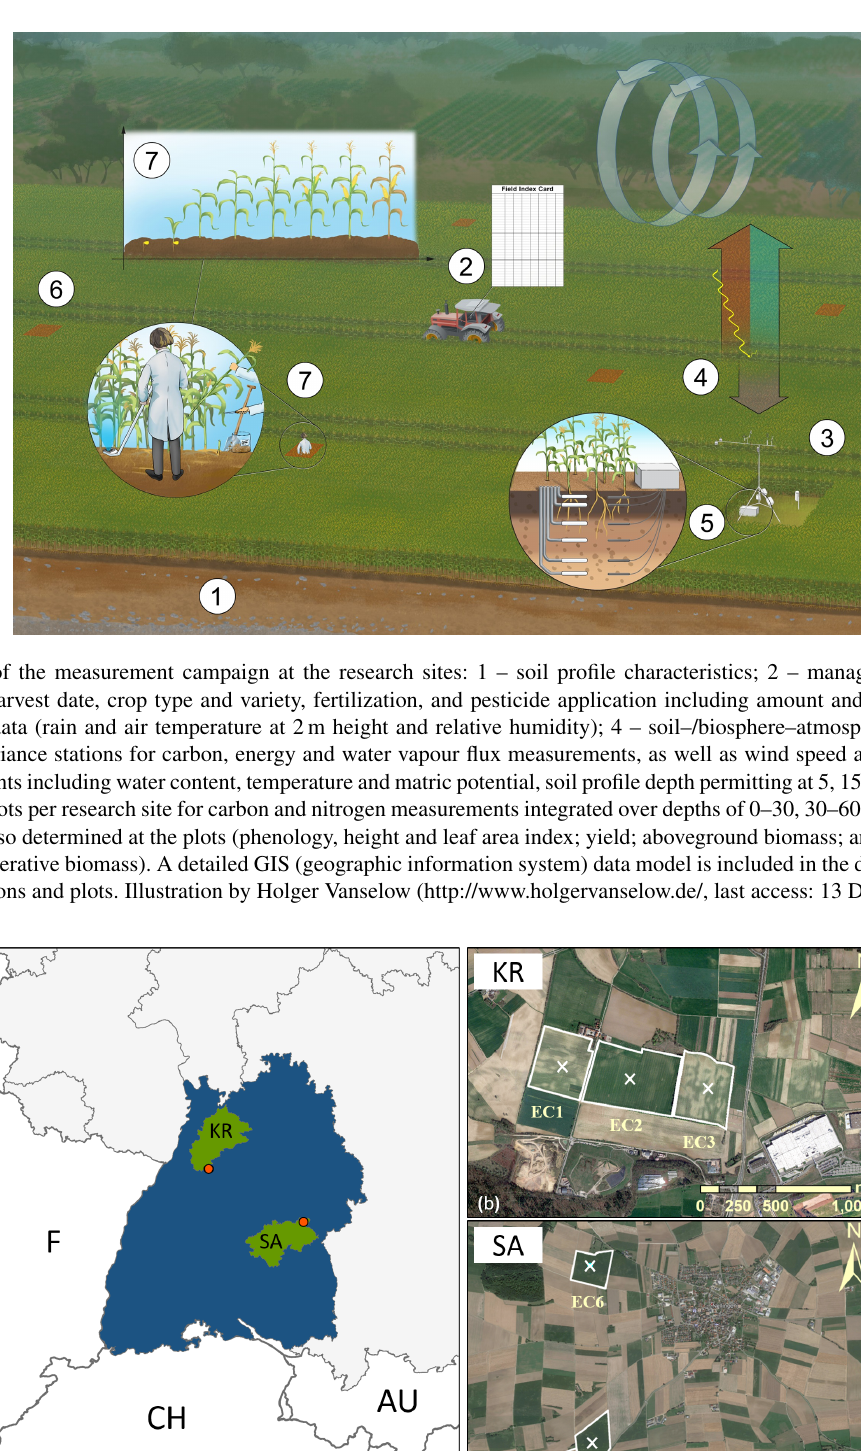
https://doi.org/10.5194/essd-14-1153-2022 Earth Syst. Sci. Data, 14, 1153–1181,